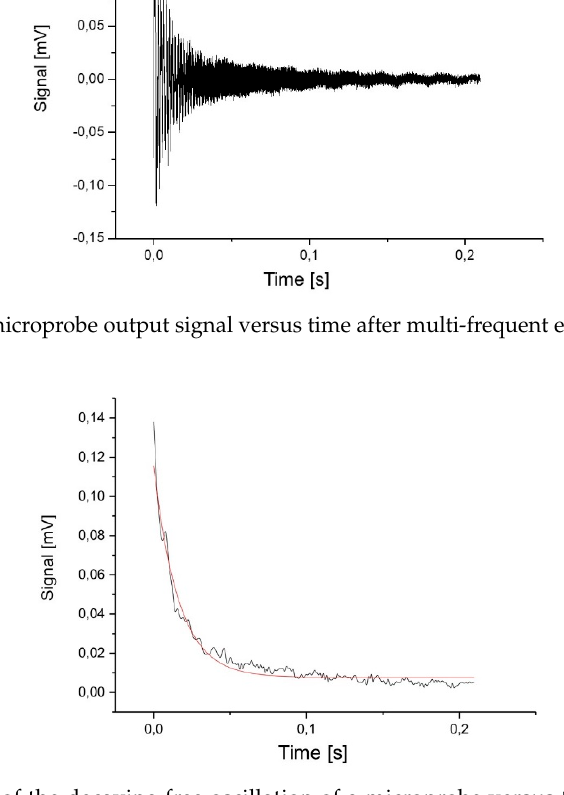
Figure 10. Envelope of the decaying free oscillation of a microprobe versus time (black) and fitted curve (red).